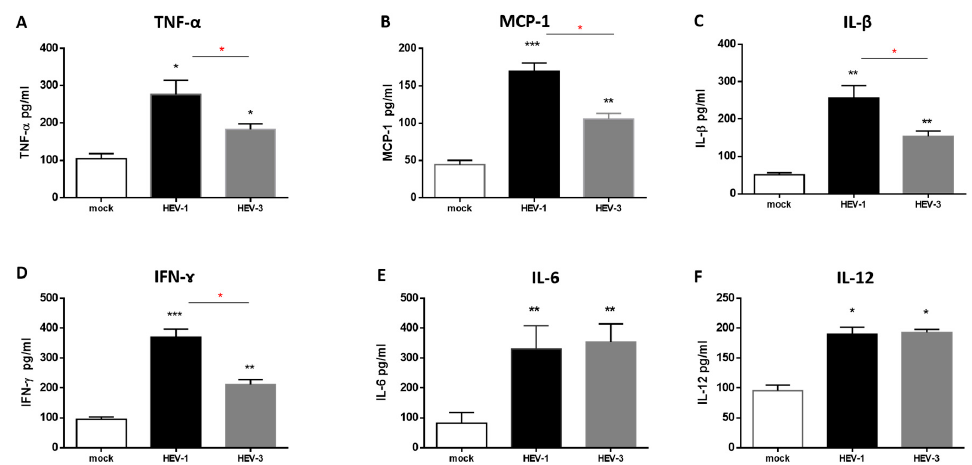
Figure 5. Immune response generated by HMACs after infection with HEV inoculums. Supernatants, collected from uninfected and HEV-infected HMACs on day 12 pi, were tested for TNF- α ( A ), MCP-1 ( B ), IL1- β ( C ), IFN- γ ( D ), IL-6 ( E ), and IL-12 ( F ) by ELISA. Depicted are the mean values of 3–5 independent experiments ± SEM. * indicates p < 0.05, ** indicates p < 0.01, *** indicates p < 0.001 as determined by unpaired two-tailed Student’s t tests. * black compared HEV infected vs. uninfected. * red compared HEV-1-infected HMAC vs. HEV-3-infected HMACs.